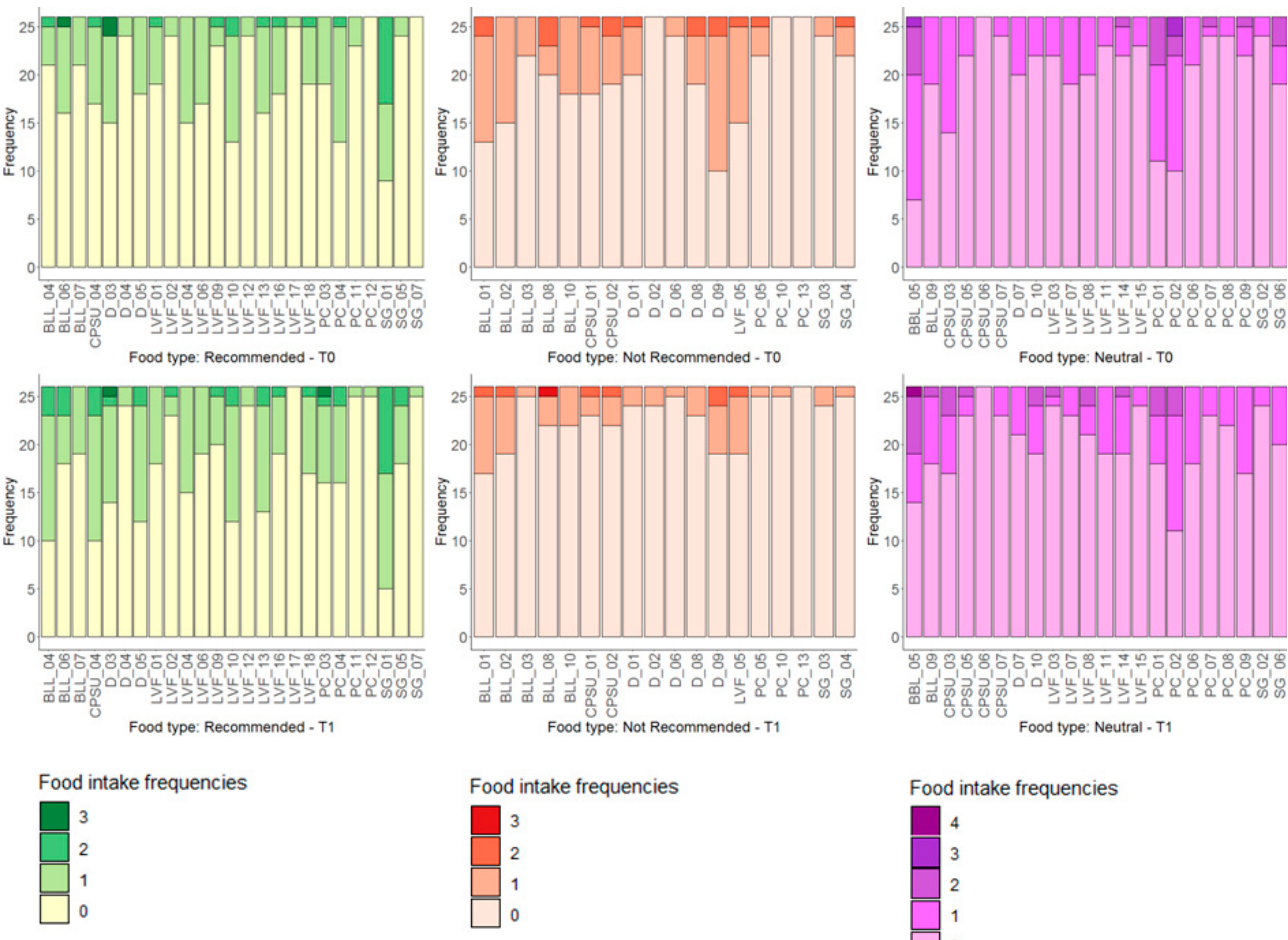
Figure 1. Distribution of food intake of Recommended, Not Recommended and Neutral at T0 (upper part) and T1 (bottom part). On the x-axis are reported the dietary items considered and on the y-axis the number of subjects according to the absolute frequency of intake. Table 1. Descriptive statistics of the three overall